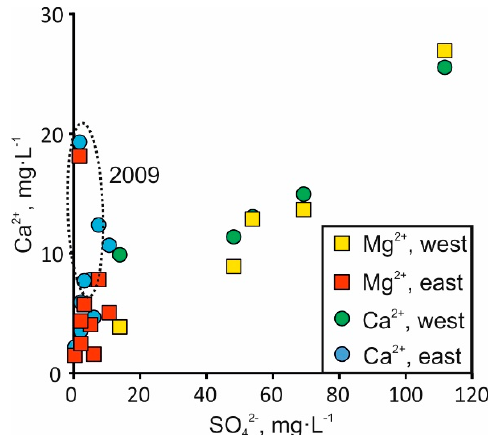
Figure 9. Ca 2+ and SO 42 − variations in subsurface water on the catchment of Lake Saana. Figure 9. Ca 2 + and SO 42 − variations in subsurface water on the catchment of Lake Saana.